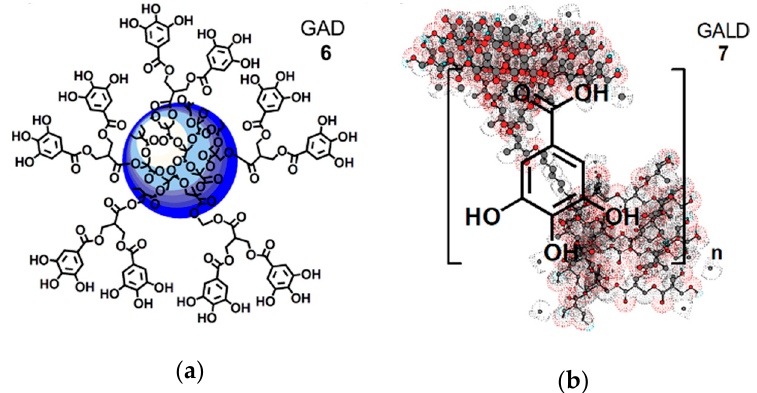
Figure 3. Simplified and intuitive representation of the GA-enriched dendrimers’ structure: ( a ) structure of the GAD nanoconjugate ( 6 ); and ( b ) structure of the GALD nanocomposite ( 7 ) encompassing the tri-dimensional representation of dendrimer 4 obtained by Chem3D Pro 7.0 software with included n molecules of GA. Concerning GAD, the blue sphere represents the inner polyester-based scaffold of dendrimer 4 [54]; the five linkers, connecting two GA molecules each, are a stylized representation of the groups actually present on the surface of 4 that in reality possesses 32 analogous structures, for a total of 64 hydroxyl groups bearing 64 GA units.